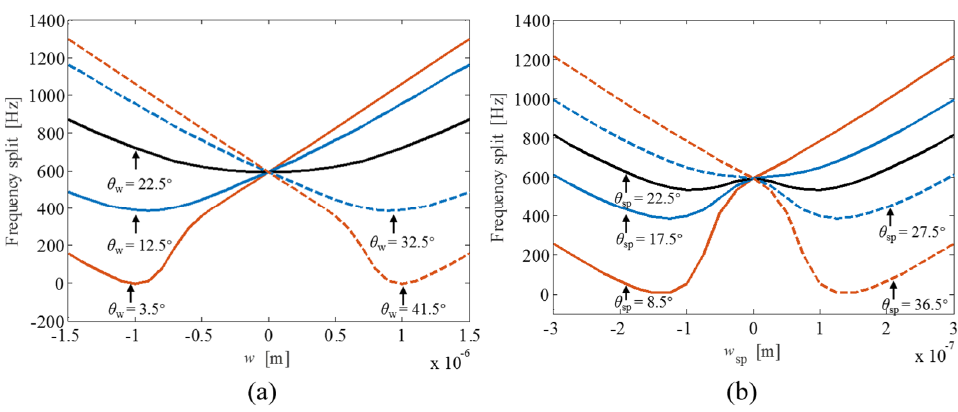
Figure 4. The influence of the width variation of both the ring ( a ) and the supporting beams ( b ) on the frequency split.